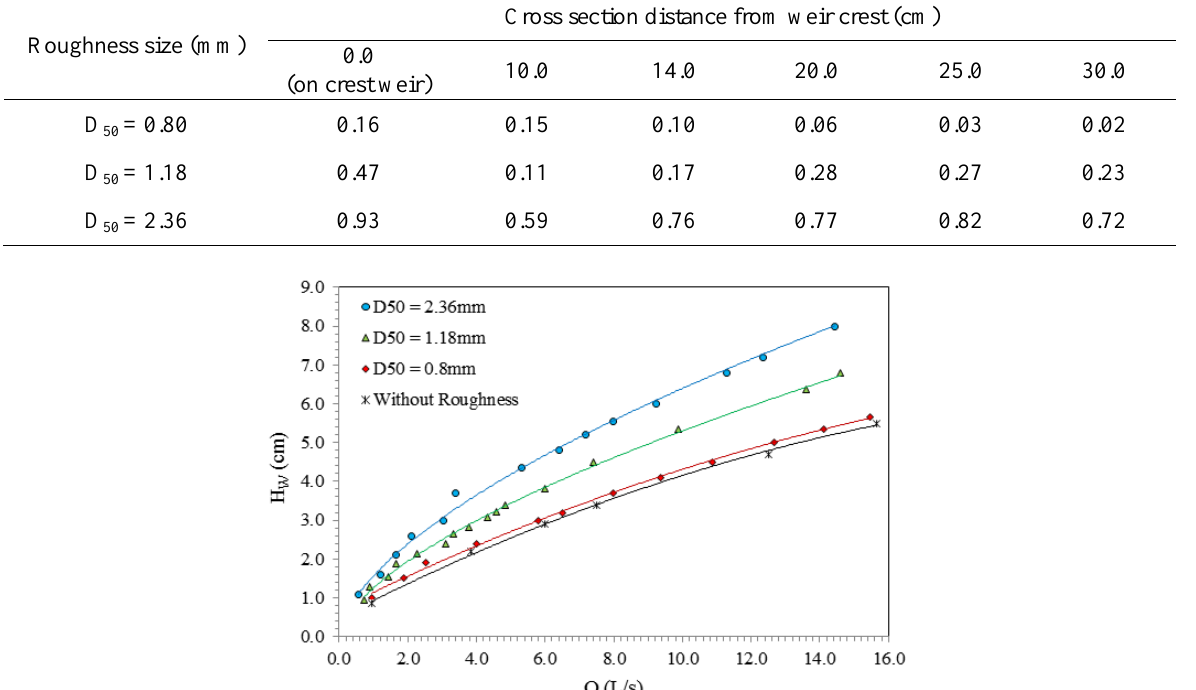
Table 1. Variation of water surface elevation (cm) for different roughness relative to non- roughness weir in different cross section upstream of weir.